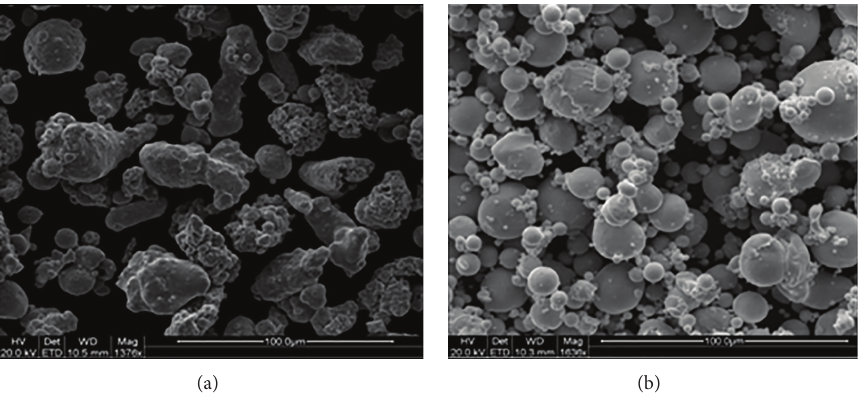
Figure 1: SEM images of the starting powders (a) Cu powder (b) 72 wt.% Ag-28 wt.% Cu